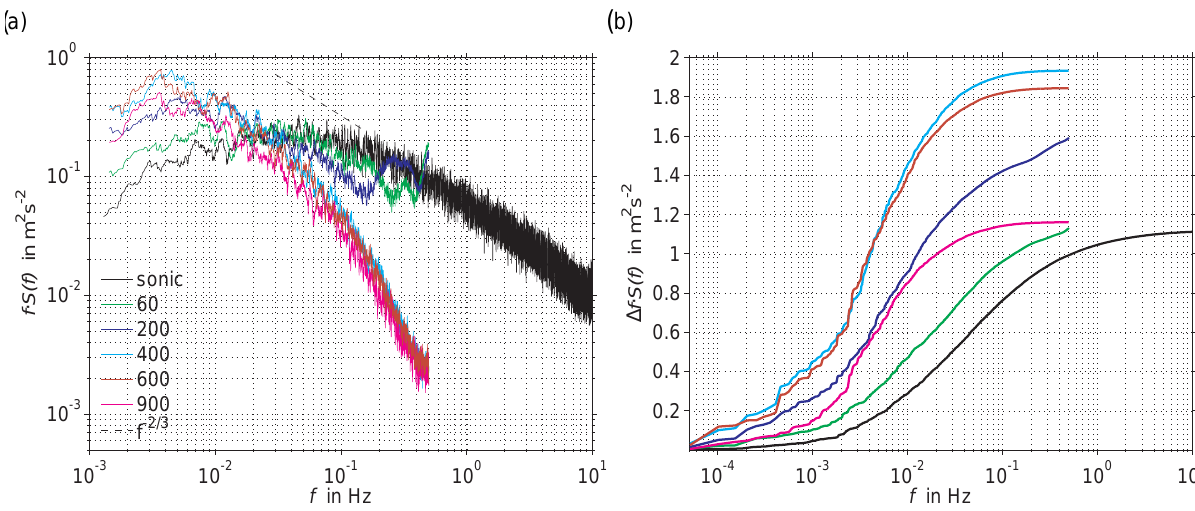
Figure 4. (a) Energy density ( S ) spectra of w at Hambach on 20 April 2013, 09:00–15:00UTC, from an ultrasonic at 30m, WLS7 (60 and 200m), and WTX (400, 600, and 900m); additionally, the theoretical slope in the inertial subrange is given; (b) as in (a) , but accumulated curves to illustrate the contributions of different frequencies to the